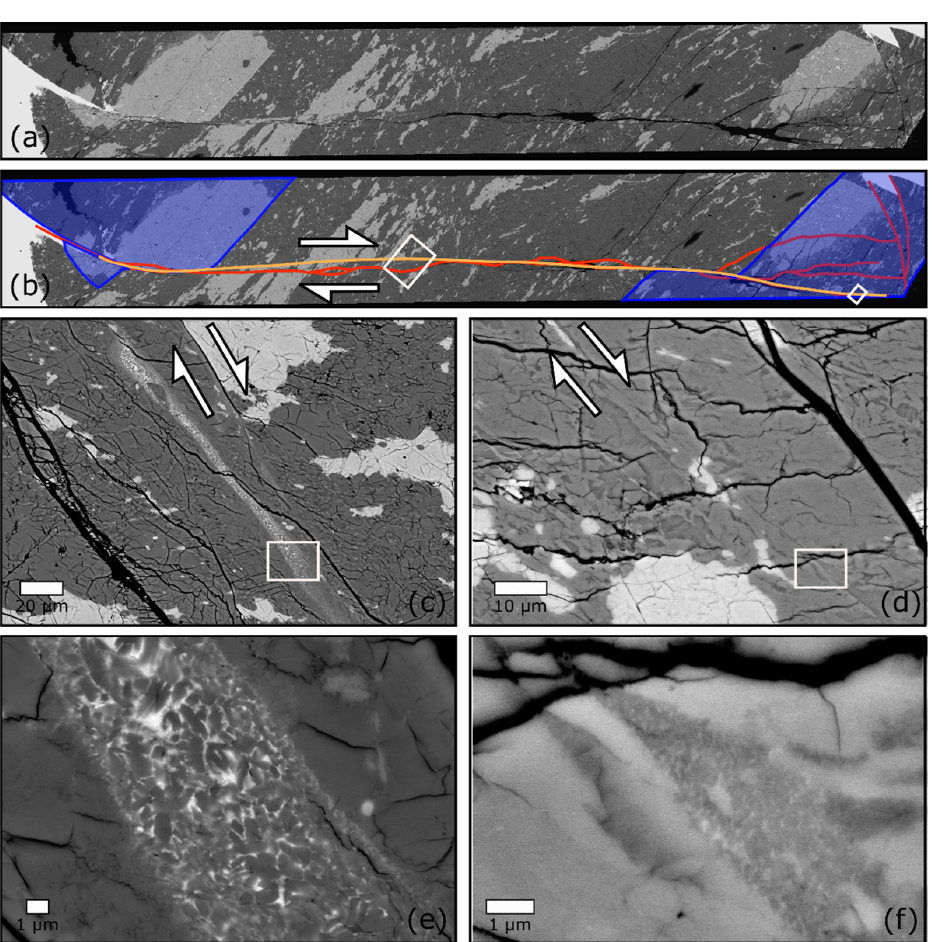
Figure 12. SEM images of the main fault in G22. ( a ) Shows an overview of the entire fault obtained by stitching multiple SEM images. ( b ) Shows the same image as in ( a ) with the main fault highlighted with the orange curve. The red lines correspond to the main mode 1 cracks that opened subsequently along the fault plane. The half-headed arrows indicate the relative motion on both sides of the fault. The blue regions correspond to the Ge-spinel bits that sandwiched the Ge-olivine sample from the beginning of the experiment. ( c ) and ( d ) correspond to the rectangles located at the center and on the right side of the image in (b), and therefore illustrate the microstructure of the fault in Ge-olivine and Ge-spinel, respectively. ( e ) and ( f ) are higher magnification images according to the rectangles in (c) and (d), respectively. These two images reveal the presence of recrystallized melt in both parts of the sample.